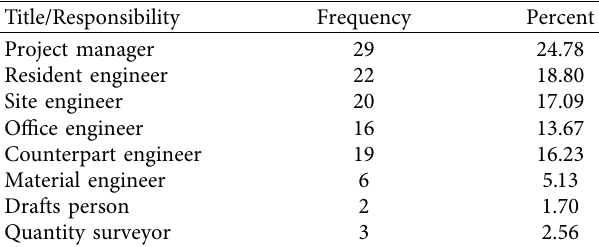
Table 3: Title/responsibility of the respondents in companies.